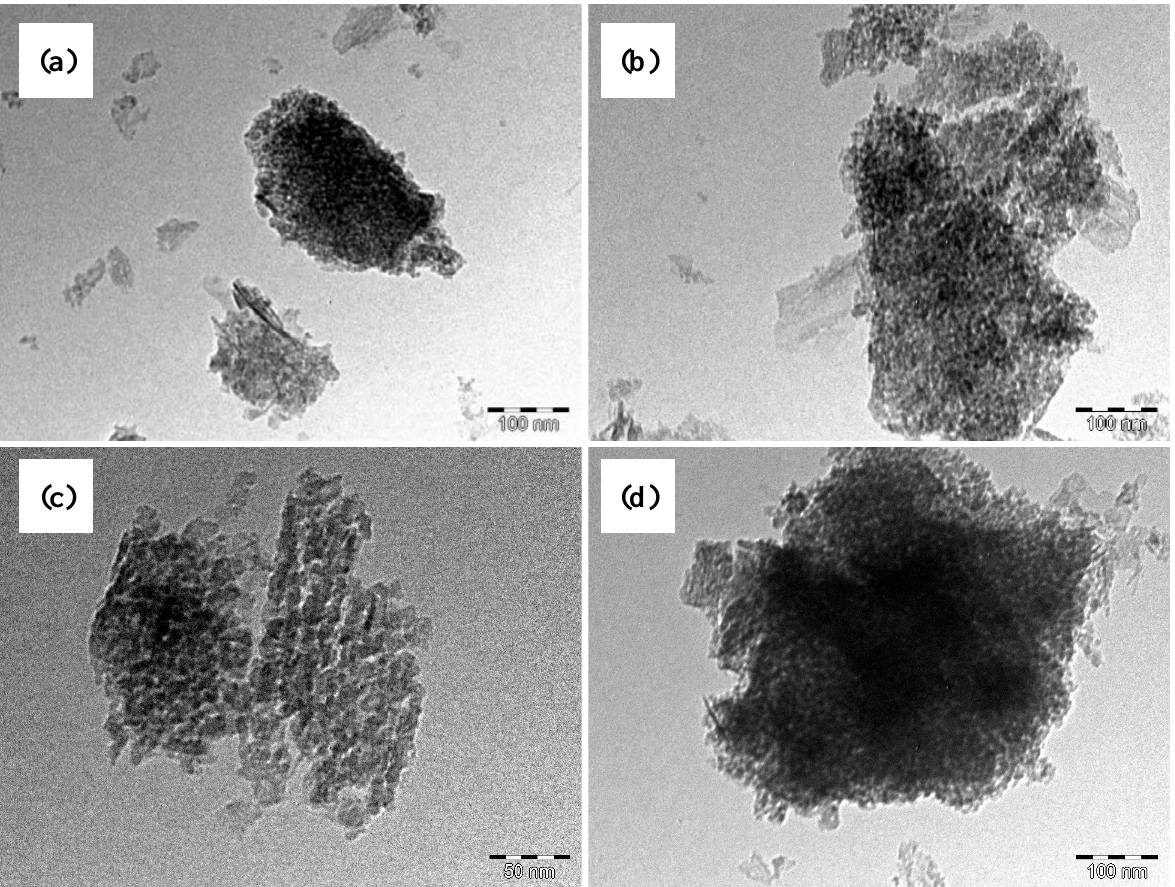
Figure 6. TEM images for ( a ) RhMo/ ɣ -Al 2 O 3 , ( b ) RhMo-EDTA/ ɣ -Al 2 O 3 , ( c ) RhMo-AA/ ɣ -Al 2 O 3 , ( d ) RhMo-CA/ ɣ -Al 2 O 3 .